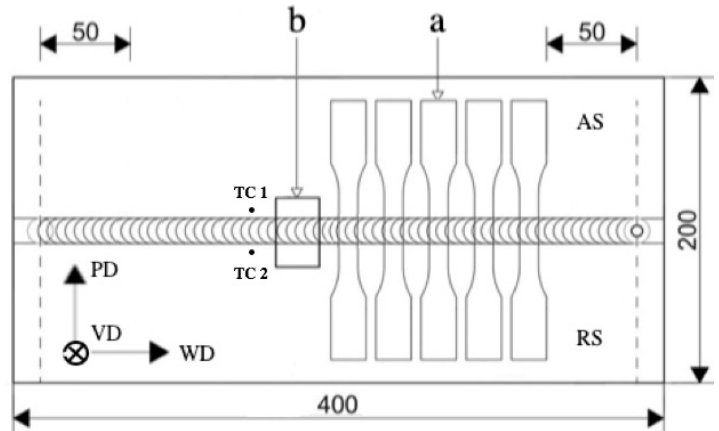
Figure 3. Locations of the specimens extracted for tensile testing (a); specimen for optical microscopy and microhardness measurement (b); TC 1 and TC 2—thermocouples for temperature measurement; WD—welding direction, PD—transverse direction, VD—vertical direction; the dimensions are mm in unit.